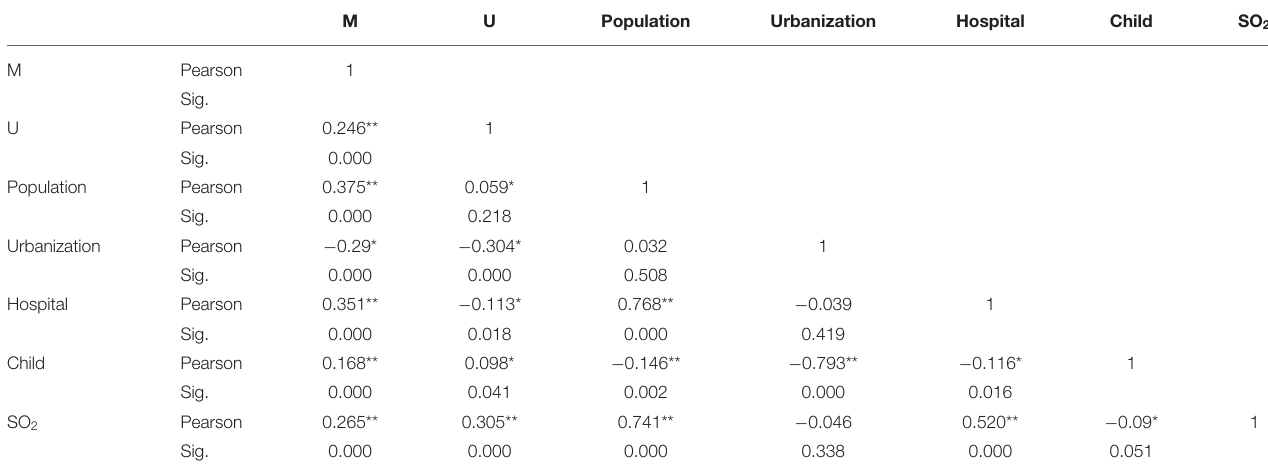
TABLE 3 | Correlation analysis of each variable.